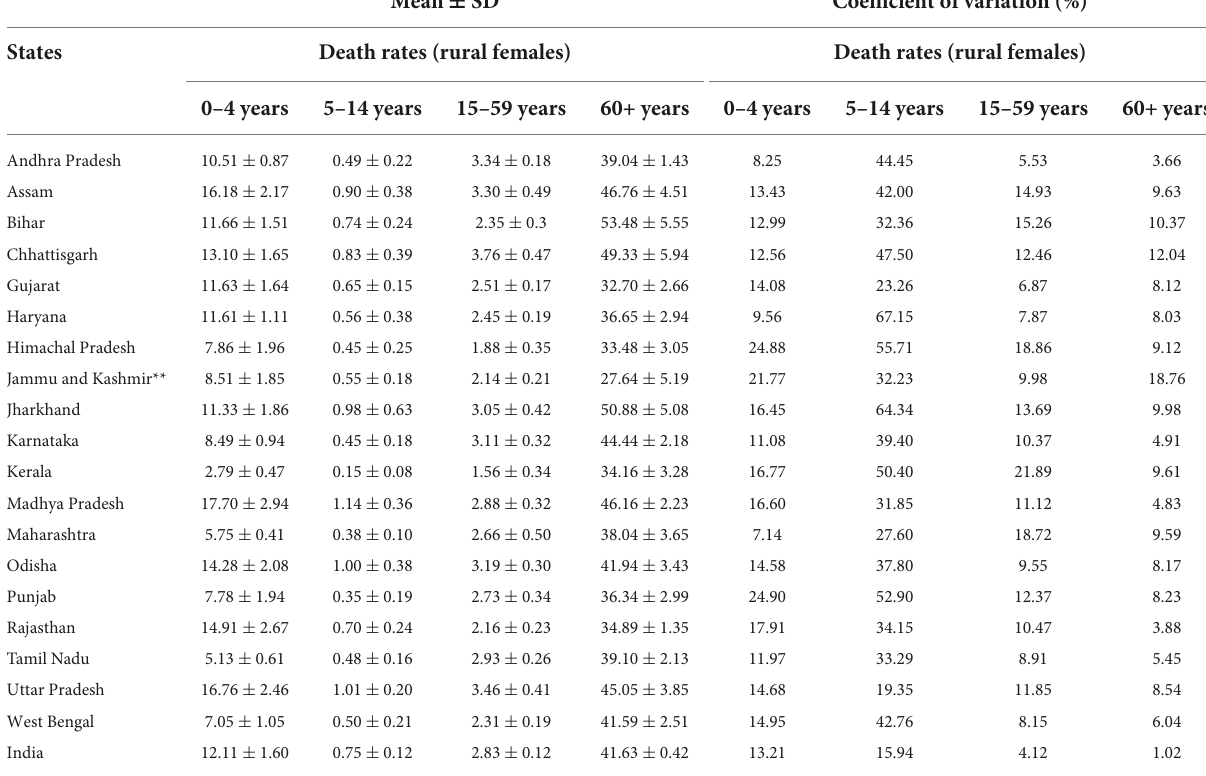
TABLE 1 Descriptive characteristics of component age groups of age-specific mortality rates of rural Indian women at the sub-national and national levels from 2011 to